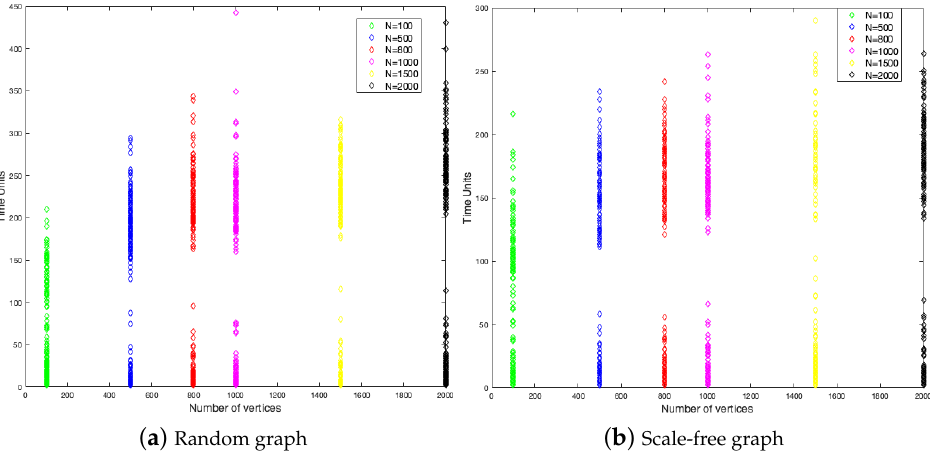
Figure 4. Duration of the disease in random and scale-free graph.